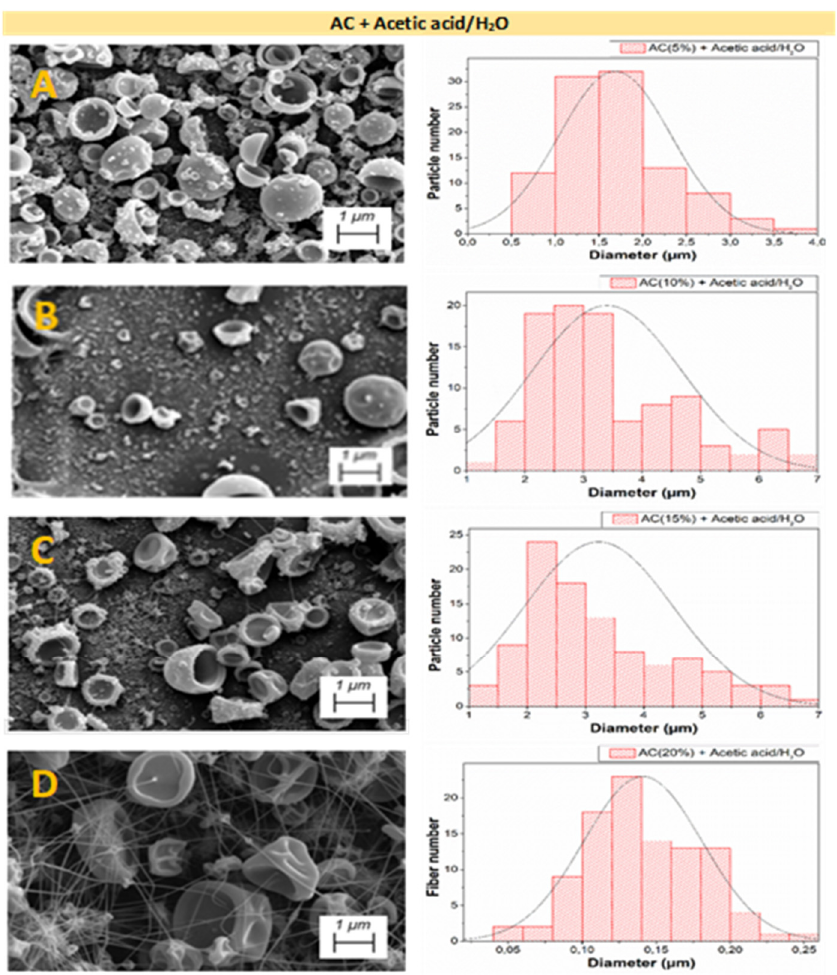
Figure 3. SEM images and distribution of microstructural properties of the nanostructures made with different AC concentrations: ( A ) 5 wt.%, ( B ) 10 wt.%, ( C ) 15 wt.%, and ( D ) 20 wt.%, using acetic acid and water as solvents. Table 3. Mean values of particles diameter, fiber diameter, and porosity obtained for the different AC and EC systems. Different letters in each column represent significant differences between the parameters ( p < 0.05).